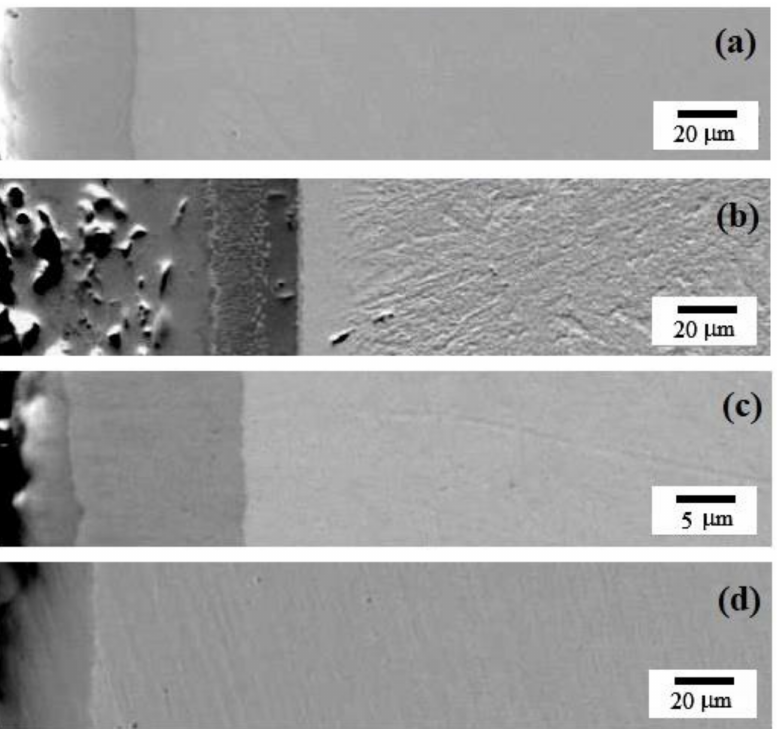
Figure 1. Backscattered electrons SEM images of the resulting layer after thermal diffusion chromium plating of the sample: ( a ) without additives; ( b ) with 5% FeV; ( c ) with 5% Mo; ( d ) with 5%